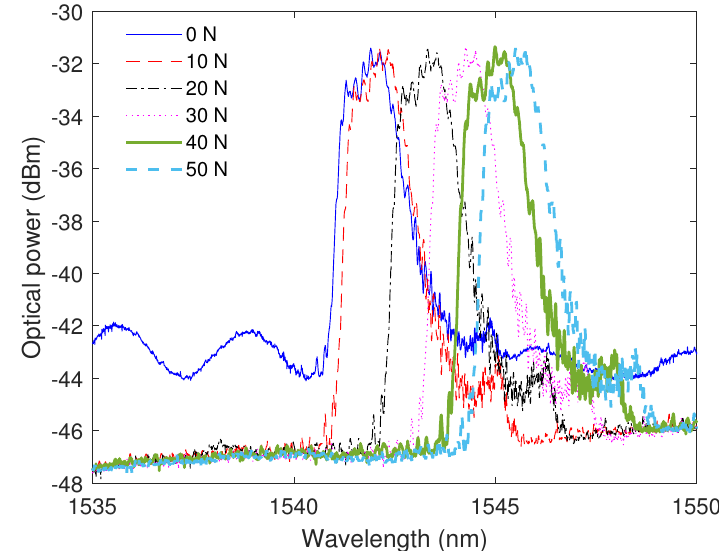
Figure 9. CFBG reflected spectra at different